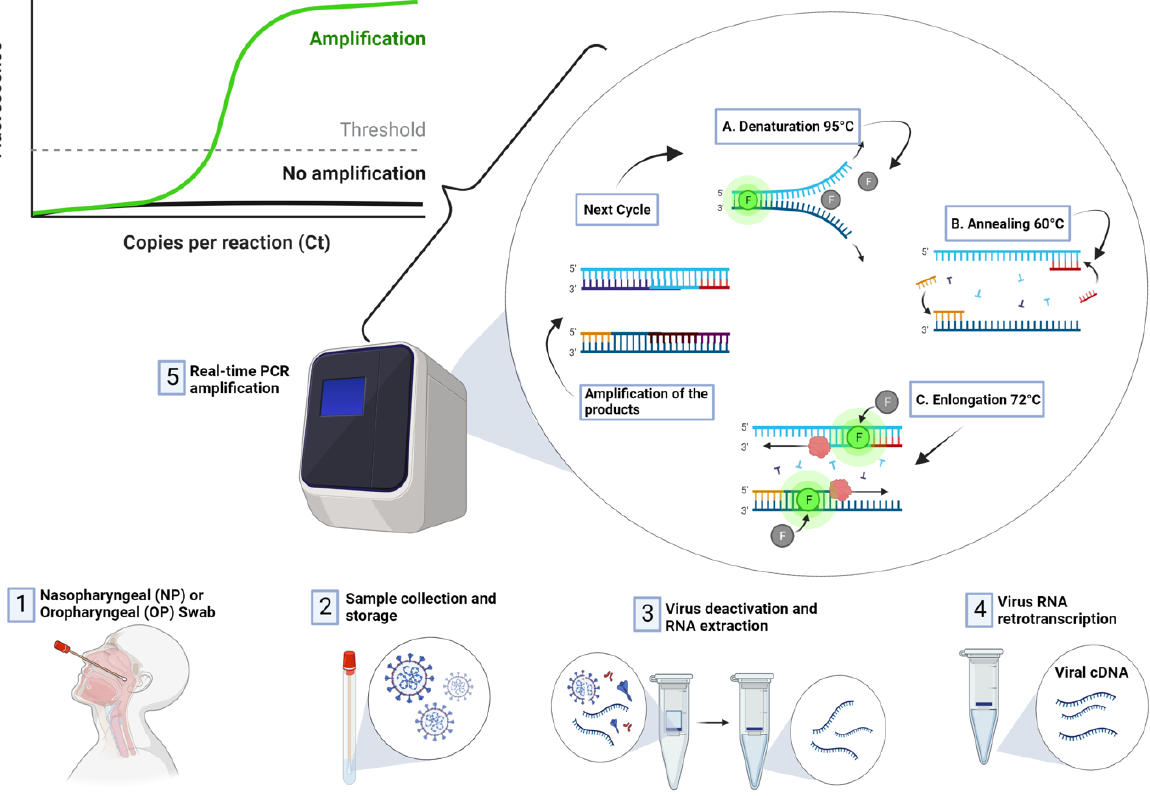
Figure 4. Detection of COVID-19 using RT-PCR Technique.